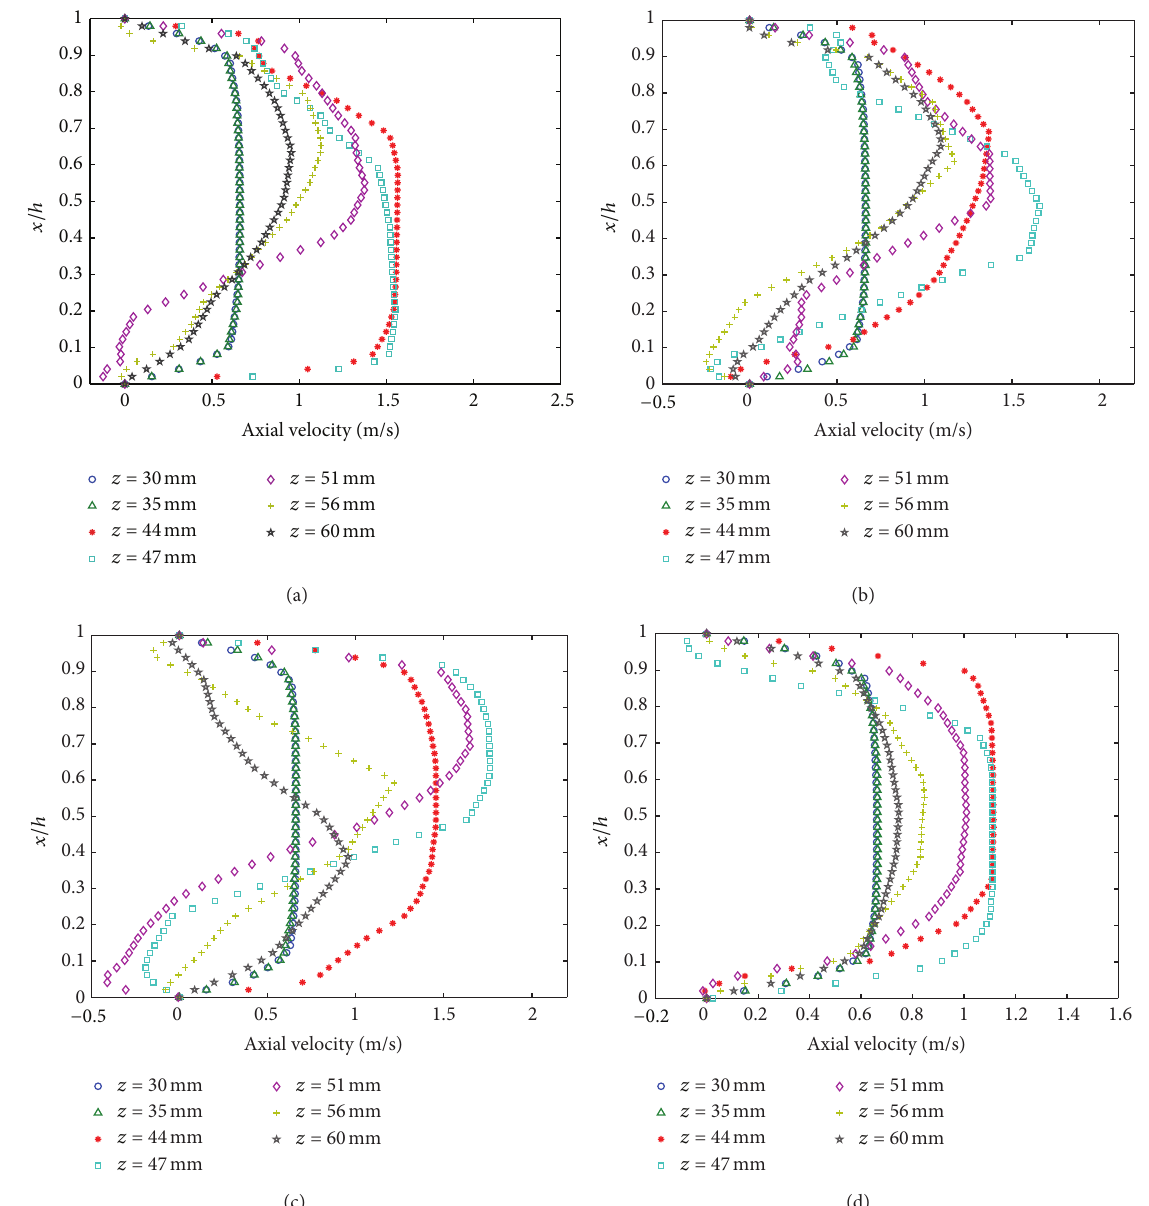
Figure 6: Axial mean velocity profiles plotted against wall-normal distance scaled by lumen height ( ℎ ) at different axial positions along the length of the artery during peak systole ( 𝑄 max ) for (a) Type I, (b) Type II, (c) Type III, and (d) Type